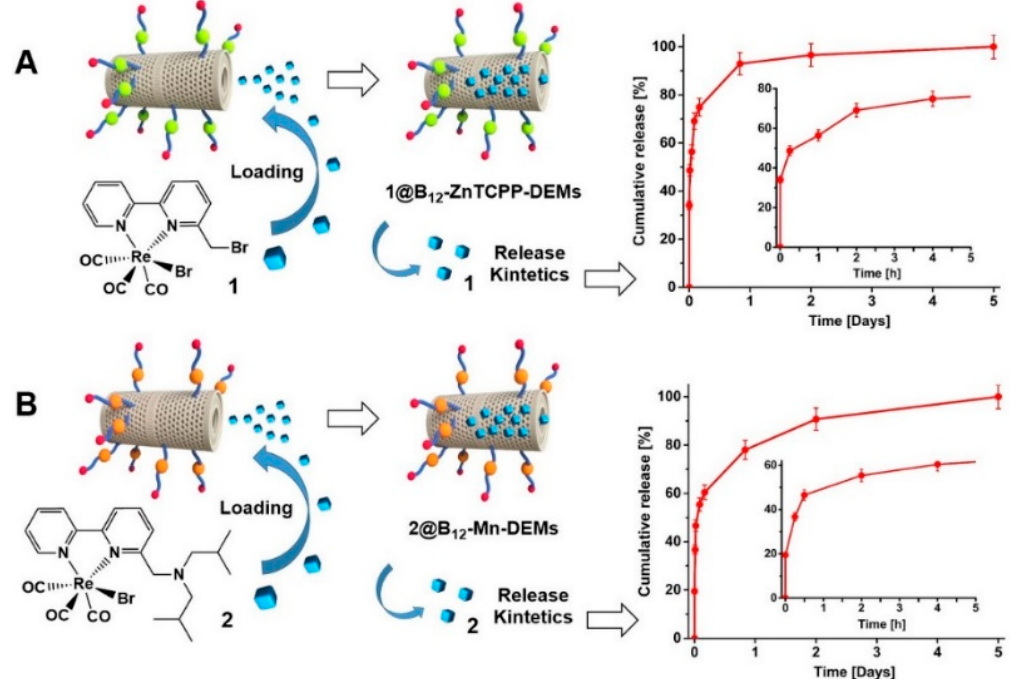
Figure 4. ( A ) Representative loading of B 12 -ZnTCPP-DEMs with complex 1 (giving 1 @B 12 -ZnTCPP-DEMs) and graph showing the release of 1 from B 12 -ZnTCPP-DEMs over a period of 5 days (insert shows release in the first 5 h). ( B ) Representative loading of B 12 -Mn-DEMs with complex 2 (giving 2 @B 12 -Mn-DEMs) and graph showing the release of 2 from B 12 -Mn-DEMs over a period of 5 days (insert shows release in the first 5 h). Table 2. Loading degrees of rhenium complexes 1 and 2 in % wt into DEMs and in vitro cytotoxicity (HCT-116 cells, IC 50 , μ M) of complexes and when administered free, in DEMs in the dark (@B 12 - X - DEMs) and in DEMs following photoactivation of their surface (@B 12 - X -DEMs- λν ).